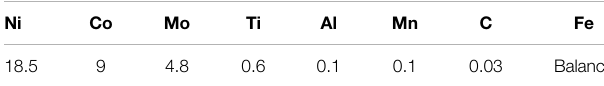
TABLE 2 | Composition of 18Ni300 in weight %